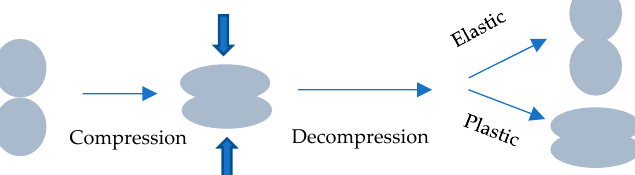
Figure 2. Schematic illustration of elastic and plastic deformation, where some pellets can behave elastically and thus expand when pressure is released—causing